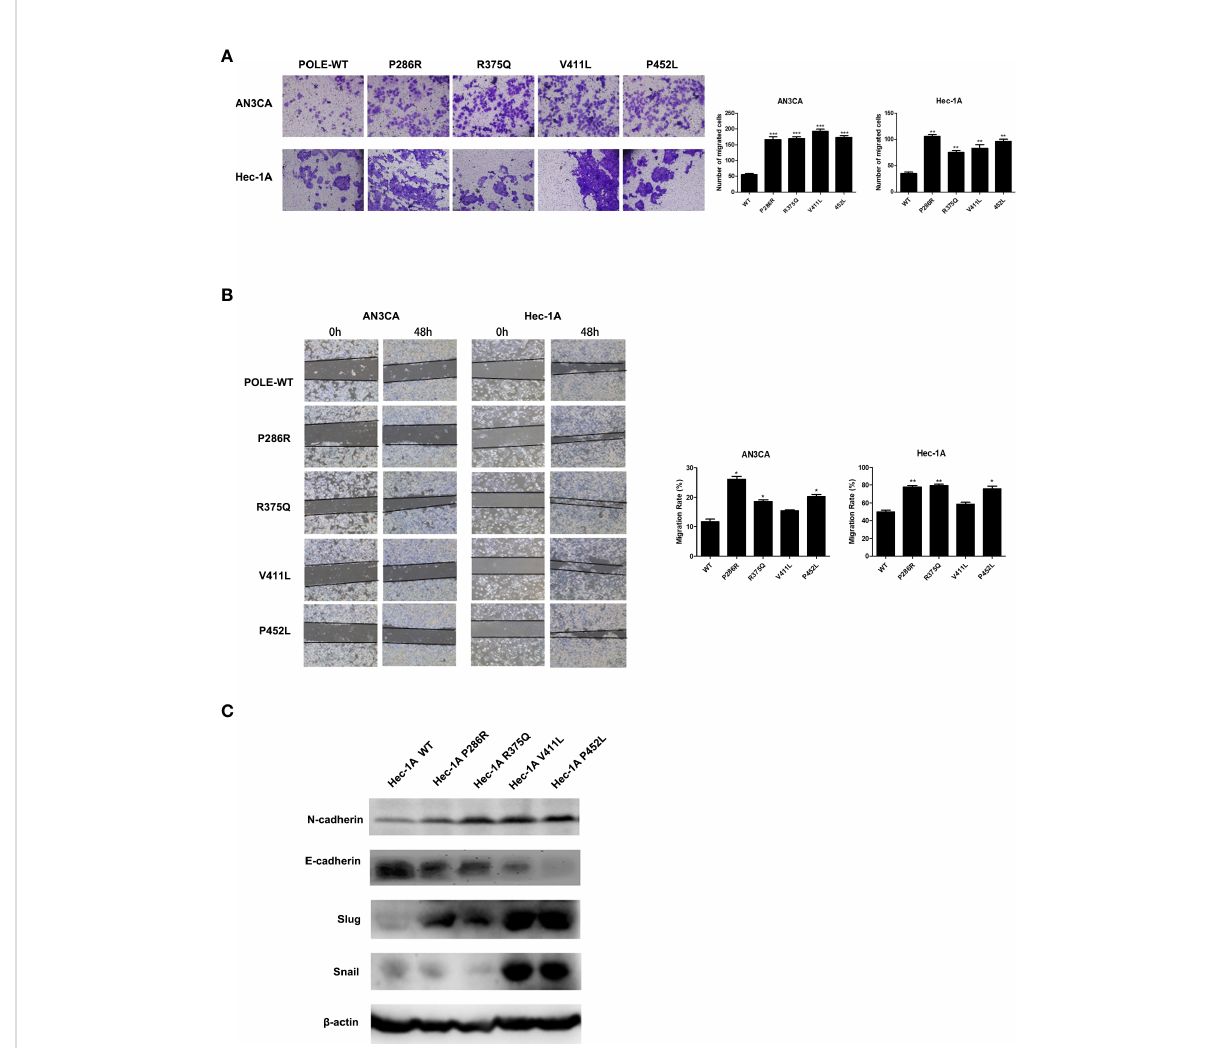
FIGURE 4 POLE EDMs promoted cell migration and invasion of endometrial cancer cells. HEC-1A cells were transiently transfected with wildtype POLE or P286R, R375Q, V411L, or P452L variant. (A) Transwell analysis was performed to examine cell invasion. (B) Wound healing assay was conducted to examine cell migration. (C) Western blot was carried out at 48 h after transfection to measure the protein levels of N-cadherin, E-cadherin, Slug, and Snail. b -actin was used as an internal reference. Data are expressed as the mean ± SD. * P < 0.05, ** P < 0.01, *** P < 0.001, vs. WT; n = 3. WT,